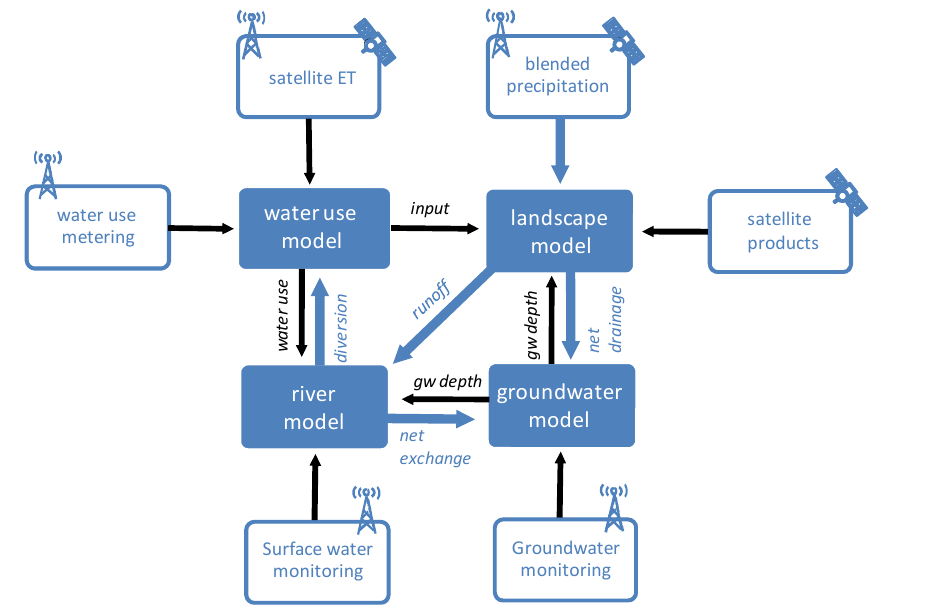
Fig. 1. Conceptual structure of the AWRA system showing the connections between models for the different hydrological processes, and the role of satellite and on-ground observations (indicated by the pictograms). Blue arrows indicate a water transfer from one model to another, black arrows indicates data flow through initialization or assimilation. Not all fluxes between models are shown and direction of water transfer can be reverse in some cases.